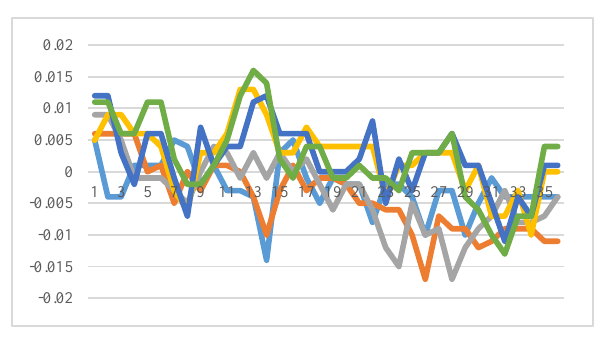
Figure 23 . Horizontal cross-sections with step 1 m.